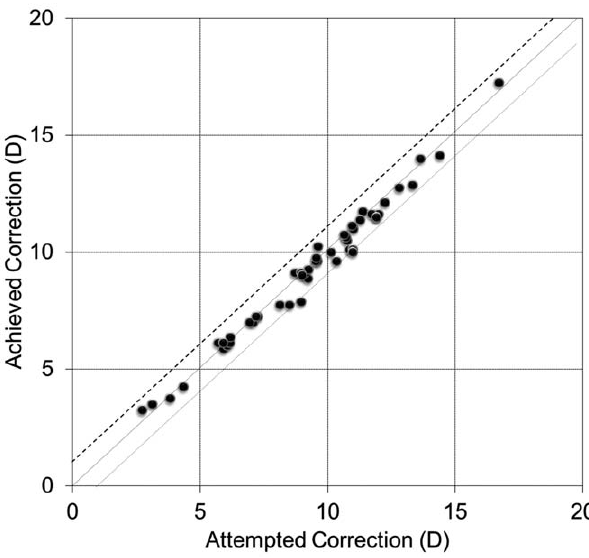
Figure 3. Scatter plot of attempted vs achieved correction (spherical equivalent) after toric implantable collamer lens implantation. D=diopter